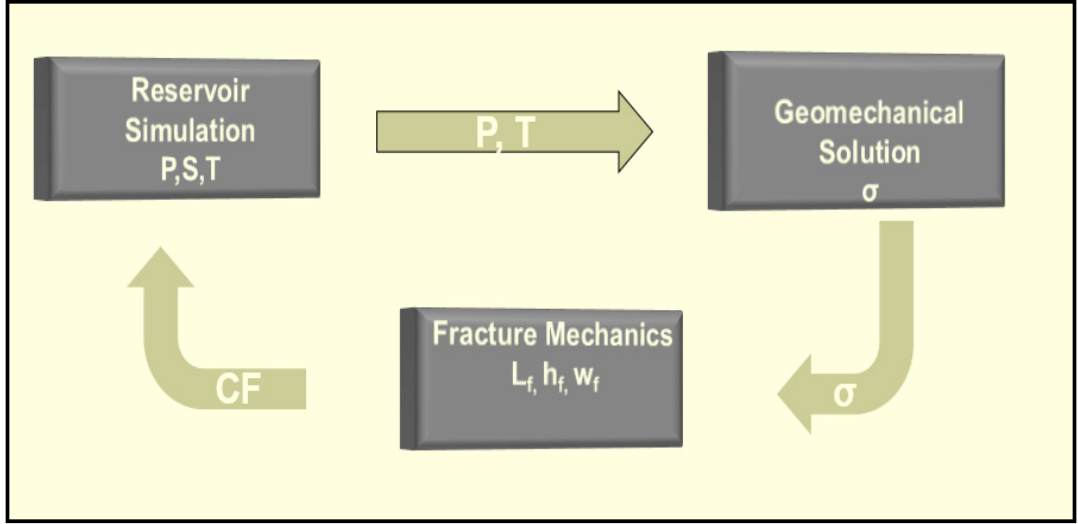
Figure 12. Workflow coupling of the reservoir model, geomechanical solution, and TIF model.